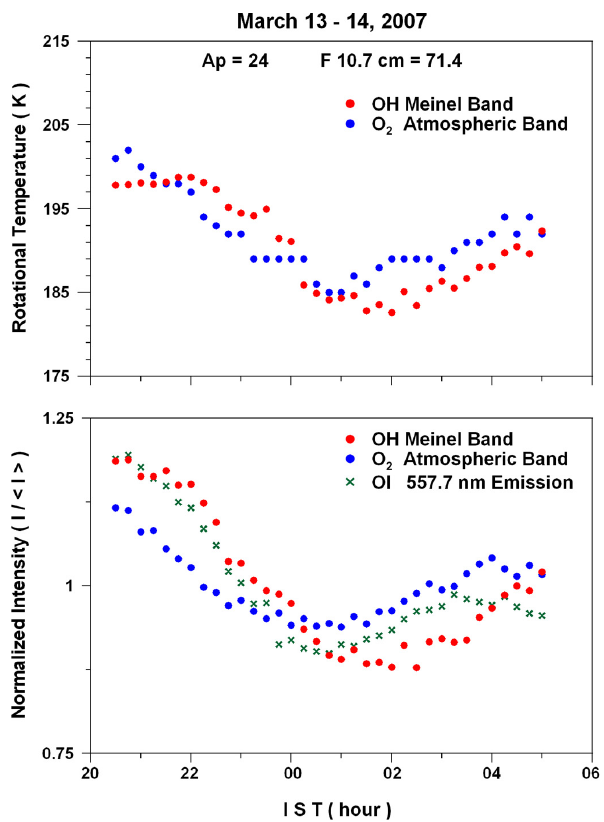
Fig. 5. Nocturnal variations of the emission intensities and derived temperature observed on 13–14 March